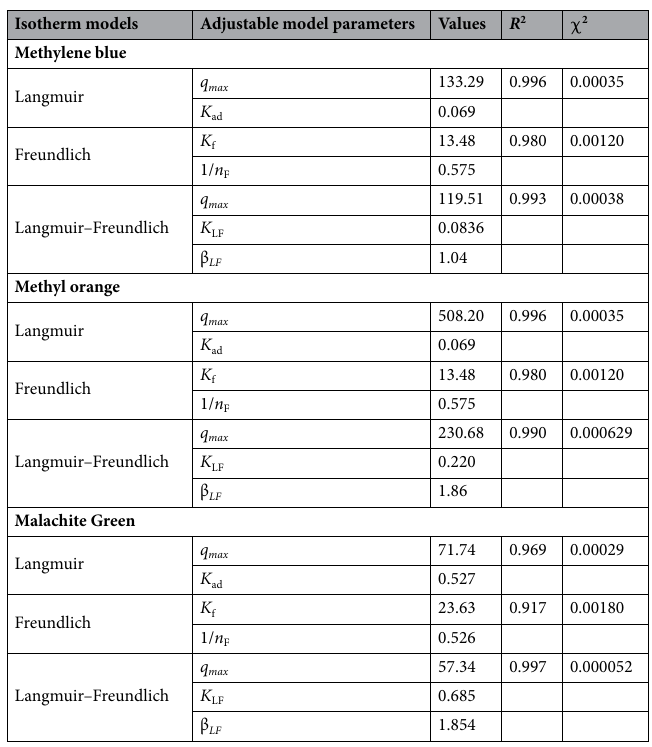
Table 1. Adsorption isotherm constants for the adsorption of MB, MO, and MG dyes in single systems.